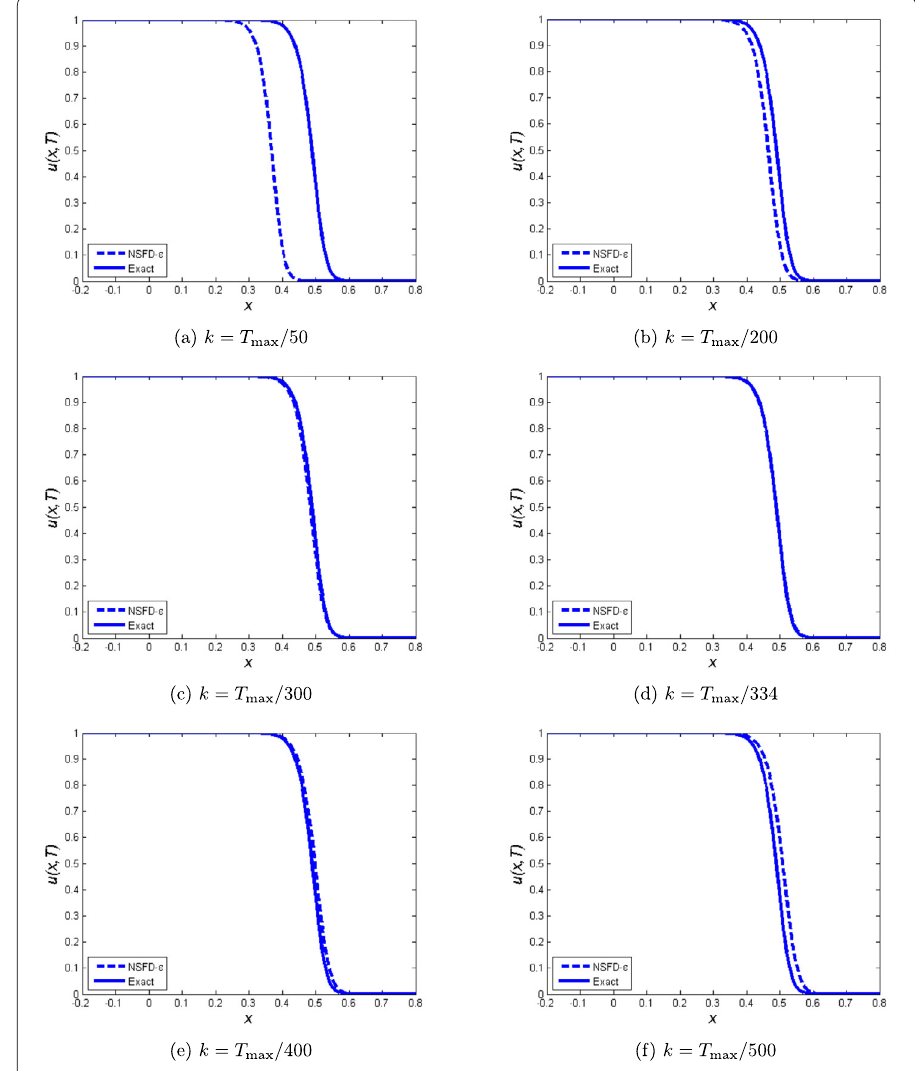
Figure 4 Plot of u against x for Problem 1 using NSFD- (cid:5) scheme at time 2.5 × 10 –3 at some different values of k and h = 0.01, (cid:5) =